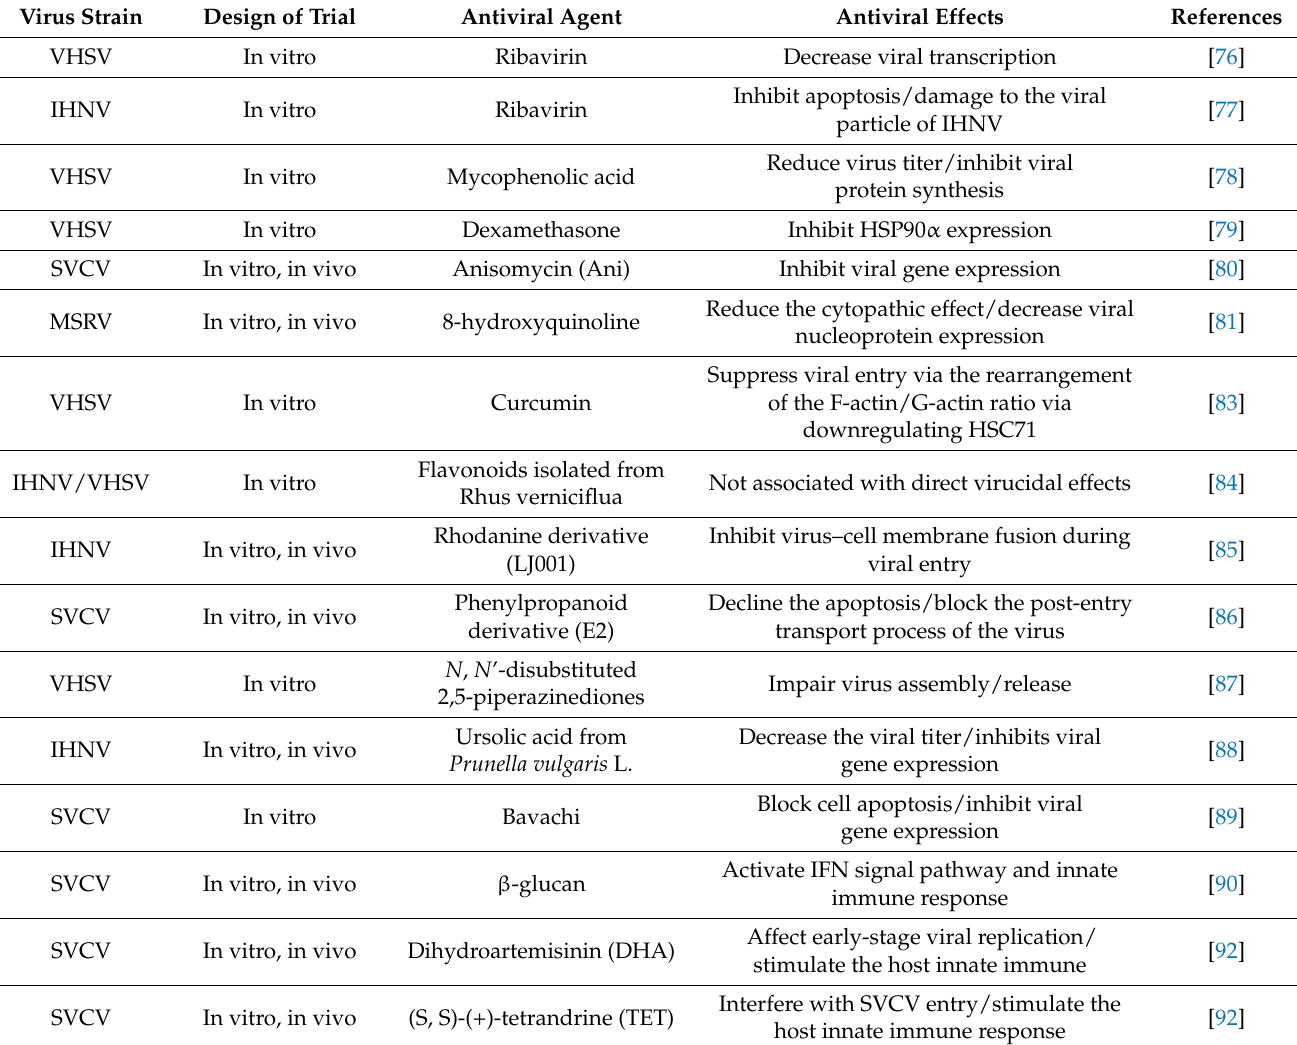
Table 7. Other organic agents against fish rhabdoviruses and their antiviral